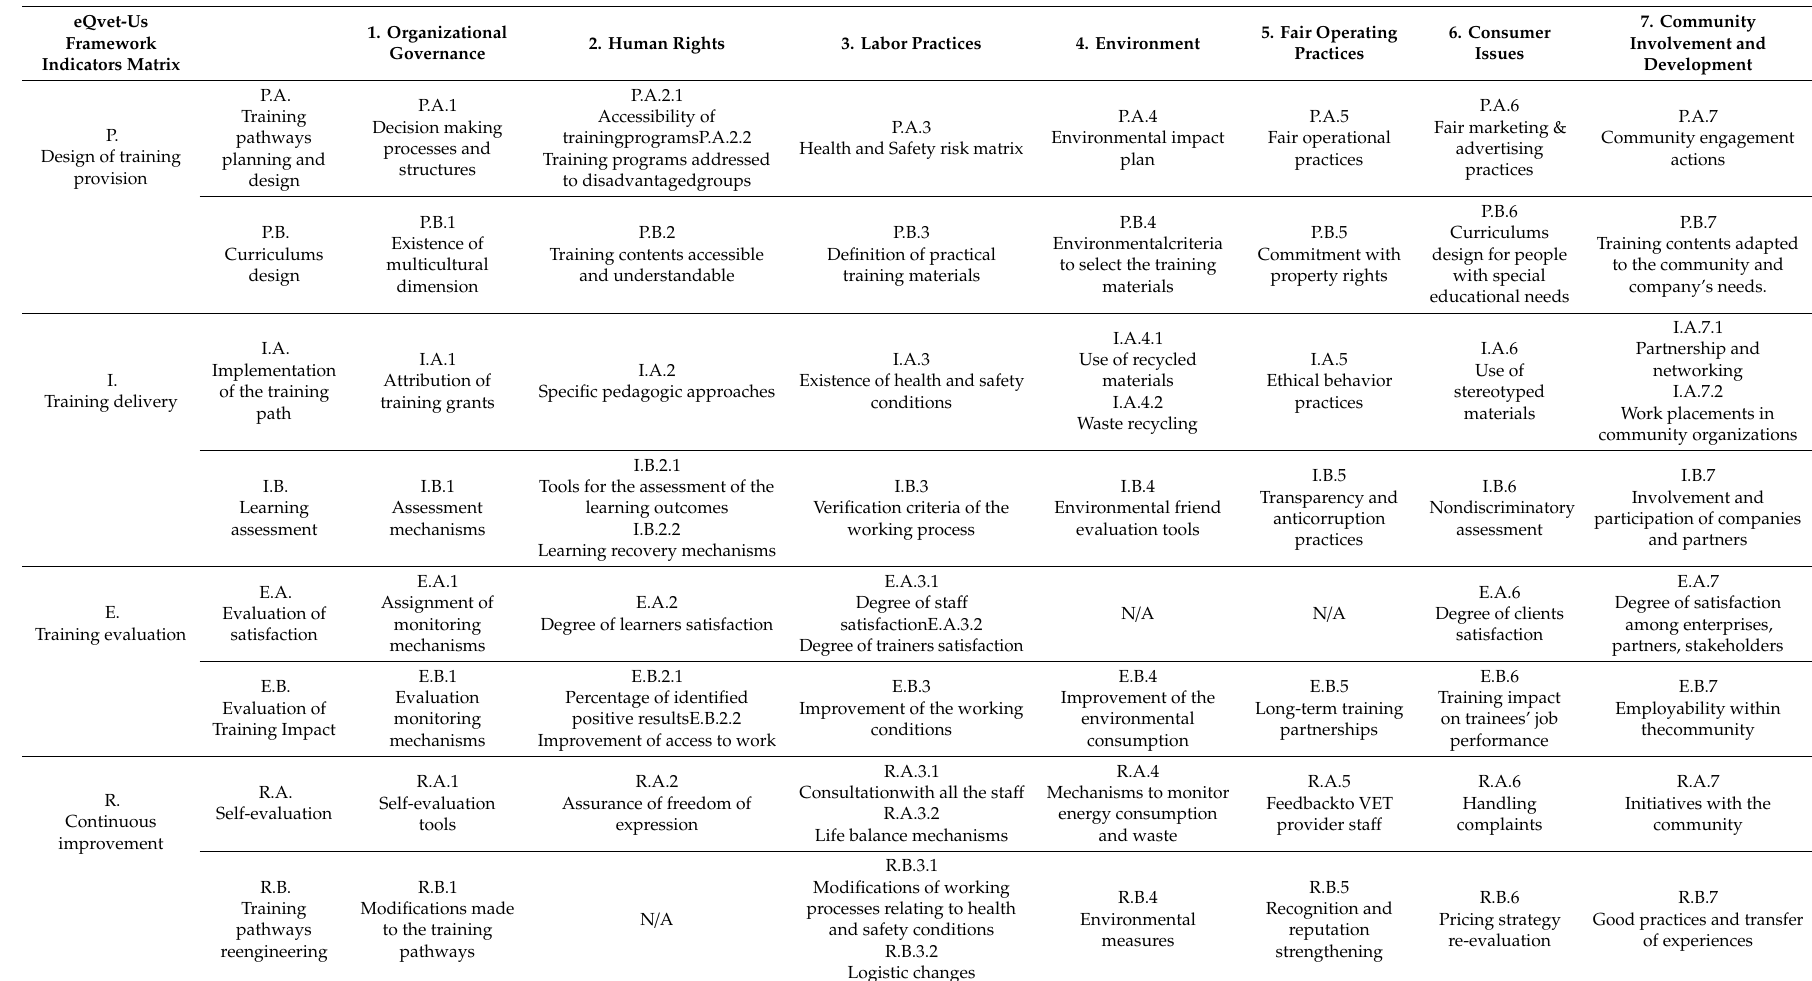
Table 1. eQvet-us framework indicators